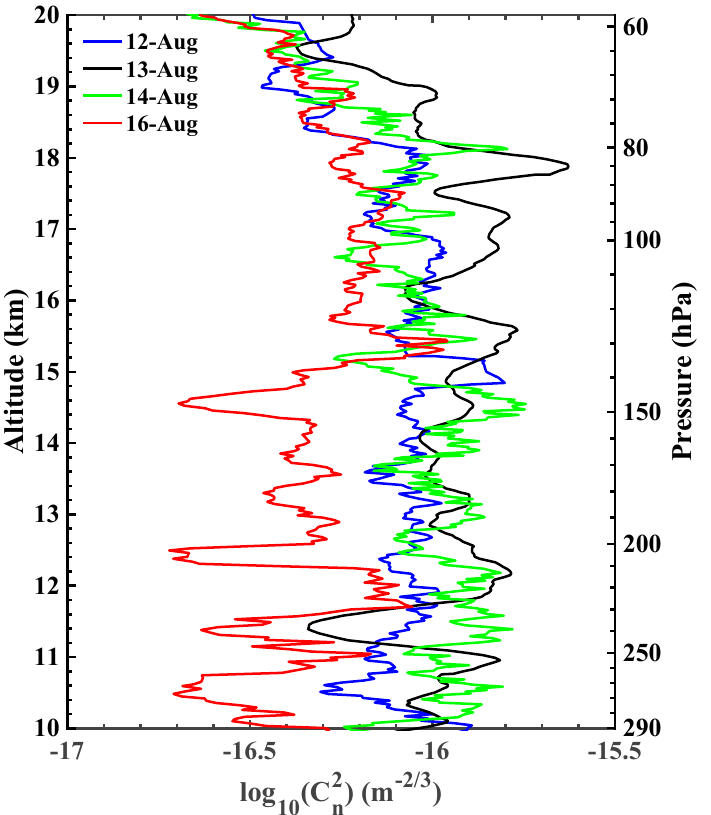
Figure 4. Vertical profiles of the atmospheric refractive index structure constant 𝐶 (cid:3041)(cid:2870) in the UTLS. 𝐶 (cid:3041)(cid:2870) was largest on 13 August and smallest on 16 August. On 12 August, ASMA had a subtle impact on the 𝐶 (cid:3041)(cid:2870) profile over Lhasa. As the ASMA center approached Lhasa and its intensity increased, 𝐶 (cid:3041)(cid:2870) increased correspondingly on 13 and 14 August. Although